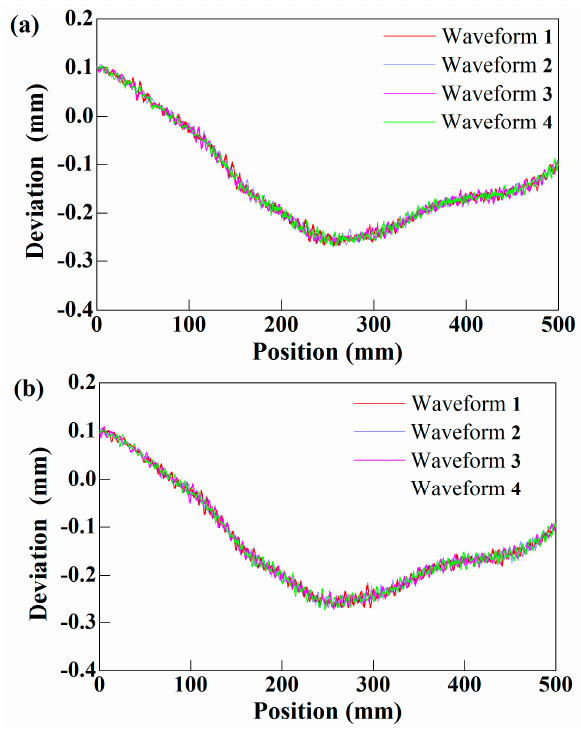
Figure 31. Combined projection waveforms of spatial sequence: ( a ) PD is the measured surface ( b ) PC is the measured surface.